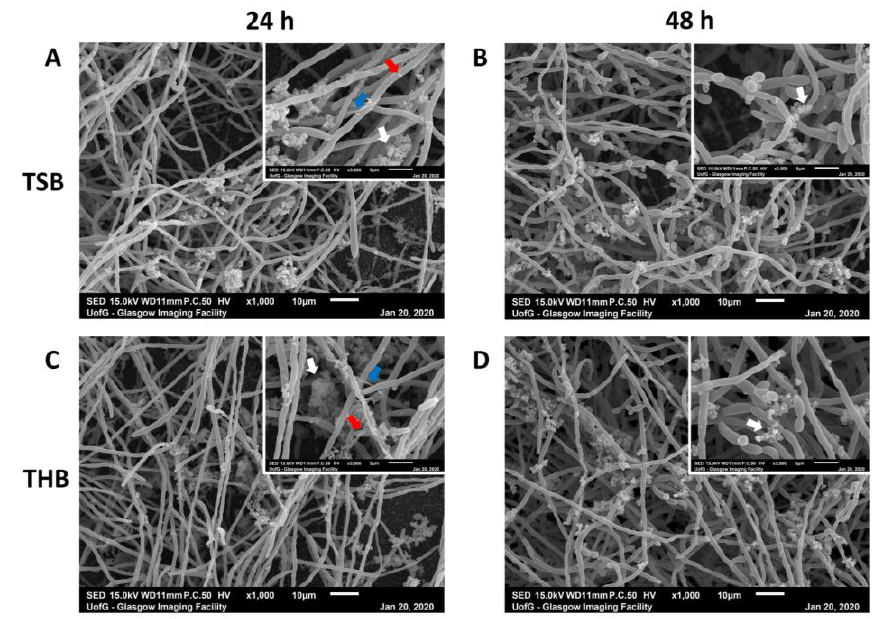
Figure 3. Scanning electron microscopy images of multi-species biofilms. Mixed biofilms were